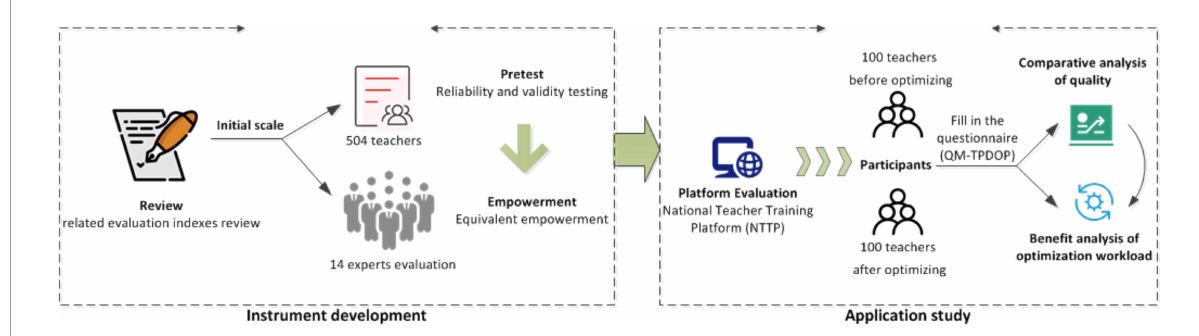
FIGURE1 Study design.